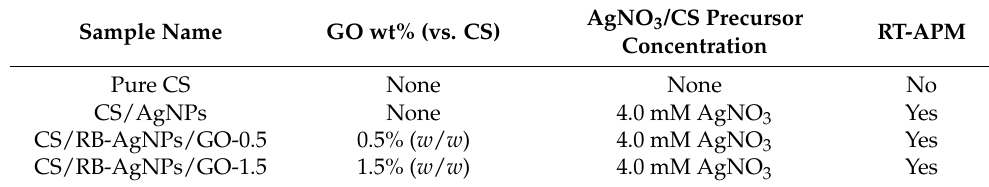
Table 1. Nomenclatures of samples and their preparation